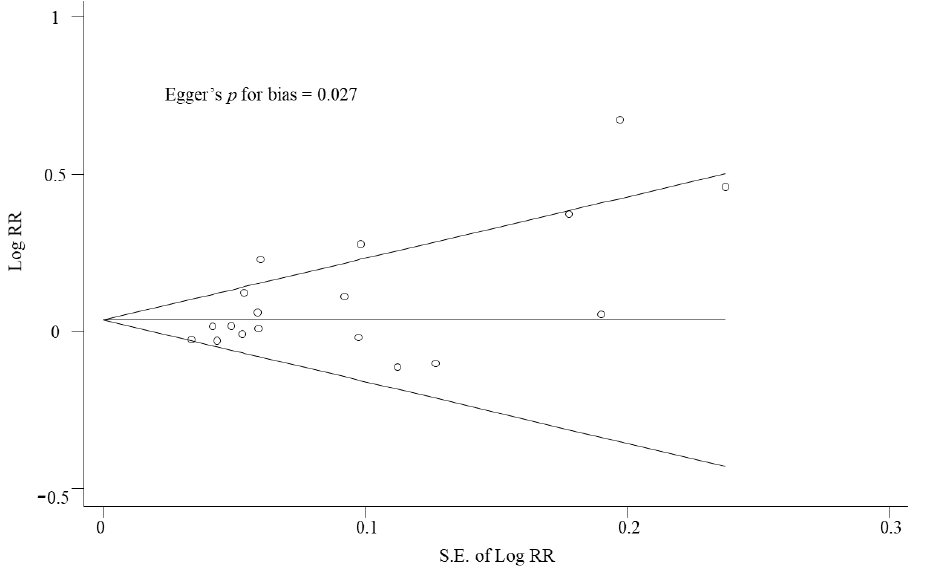
Figure 3. Begg’s funnel plots and Egger’s test for identifying publication bias. RR, relative risk; S.E., standard error.